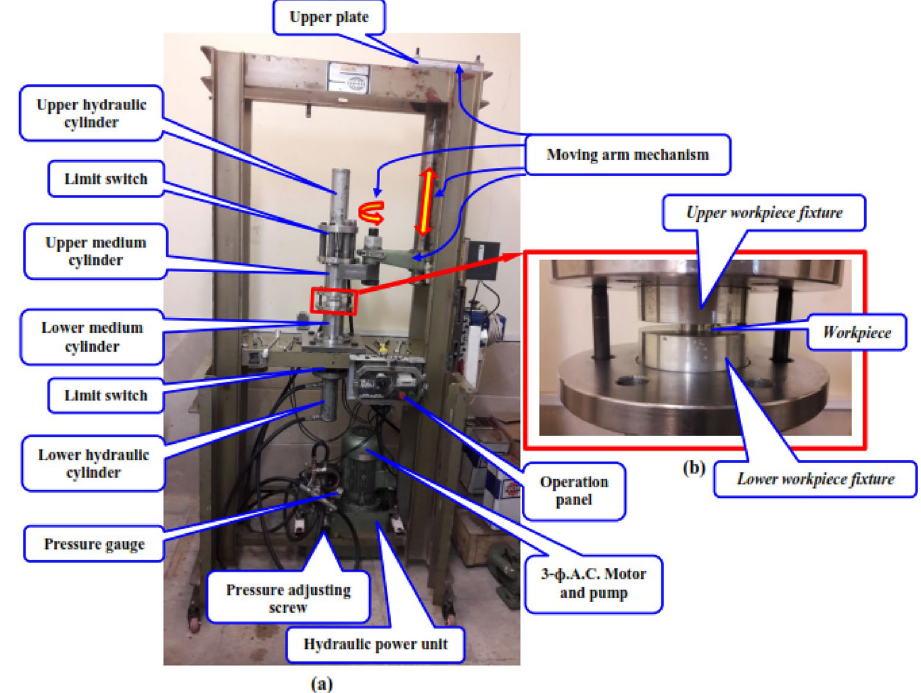
Fig. 2 a , b The AFM experi- ment machine for internal machining of